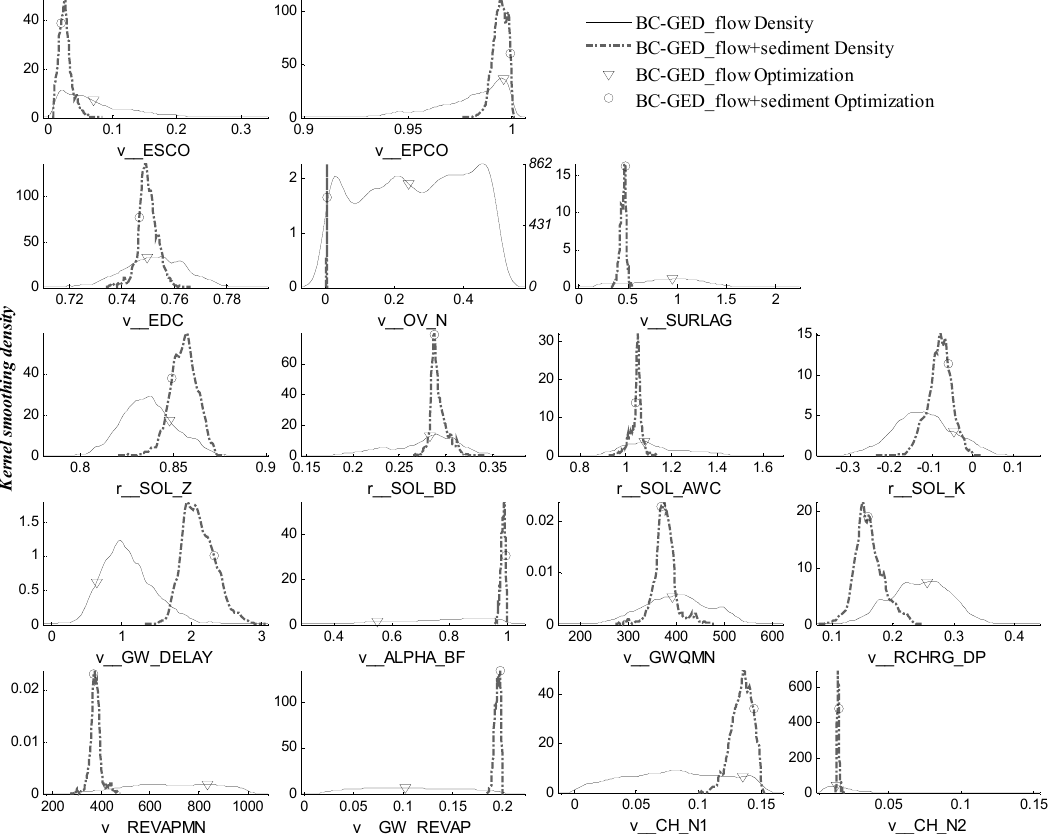
Figure 10. Comparison of the posterior distribution and optimal value (point) of flow parameters estimated by the single- (solid line) and multi- objective (dash line) BC-GED approaches.